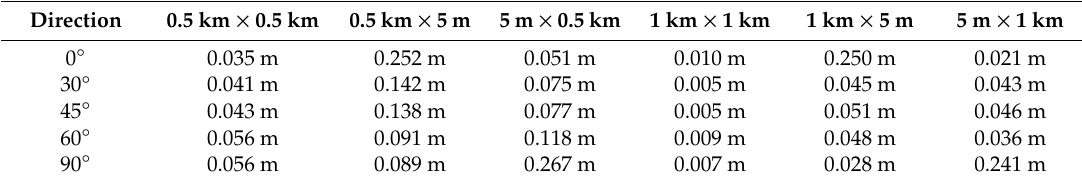
Table 8. The root mean square (RMS) of smoothing velocity bunching height inversion results with di ff erent swell propagation directions (the direction of the smoothing window is in two directions at the same time, in the azimuth and in the range).